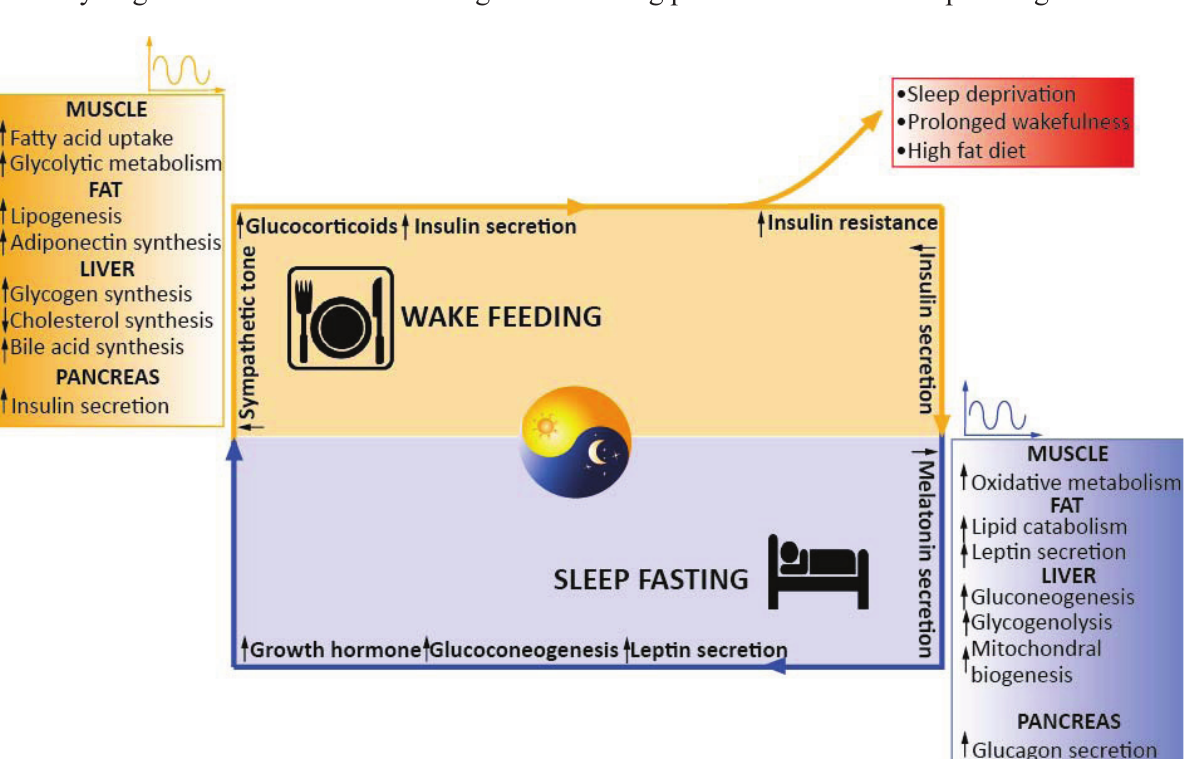
Figure 3. Schematic view of the tight association between circadian rhythms, metabolism and hormonal homeostasis in humans. Waves symbolises circadian regulation. See text for